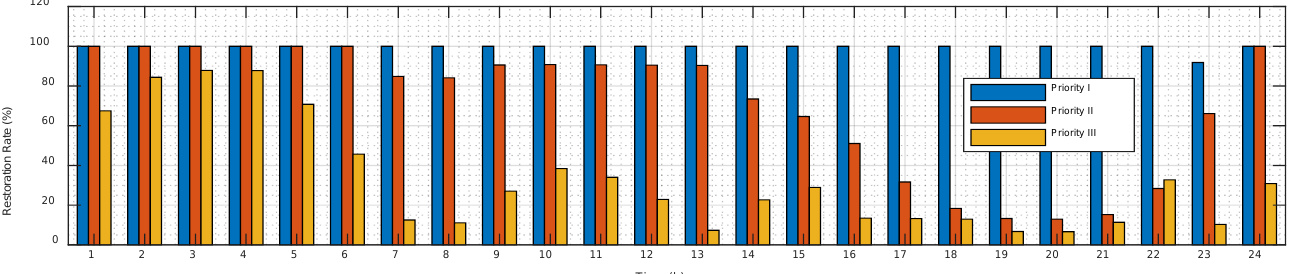
Figure 8. Restoration ratios for Scheme I.